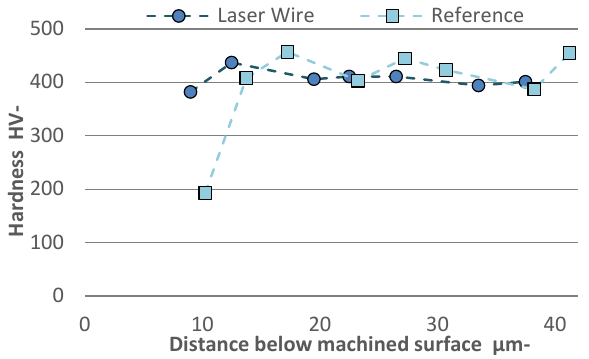
Figure 14. Microhardness profile of LW and reference materials. Measurements taken from the surface level into the bulk.